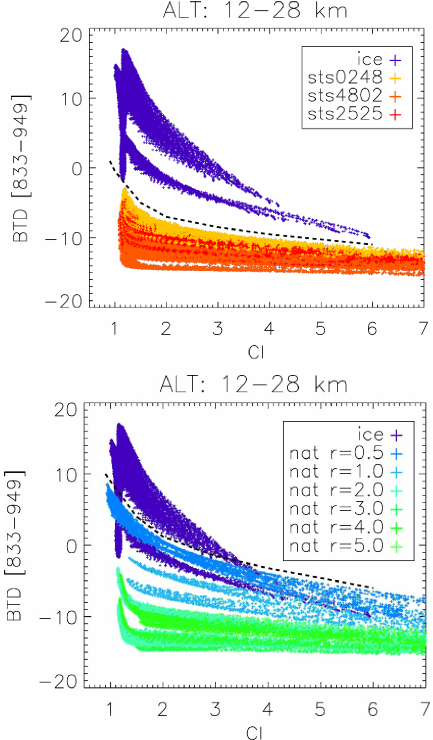
Figure 4. Modelled cloud index (CI) vs. brightness temperature dif- ference between 833 and 949cm − 1 for all PSC scenarios of the CSDB. Top: for ice compared to three STS compositions (colour- coded; see also Table 1), and bottom: ice compared to NAT (colour- coded NAT radii). Superimposed dashed lines separate ice events from the corresponding second PSC composition in the figure, STS (top) and NAT (bottom),